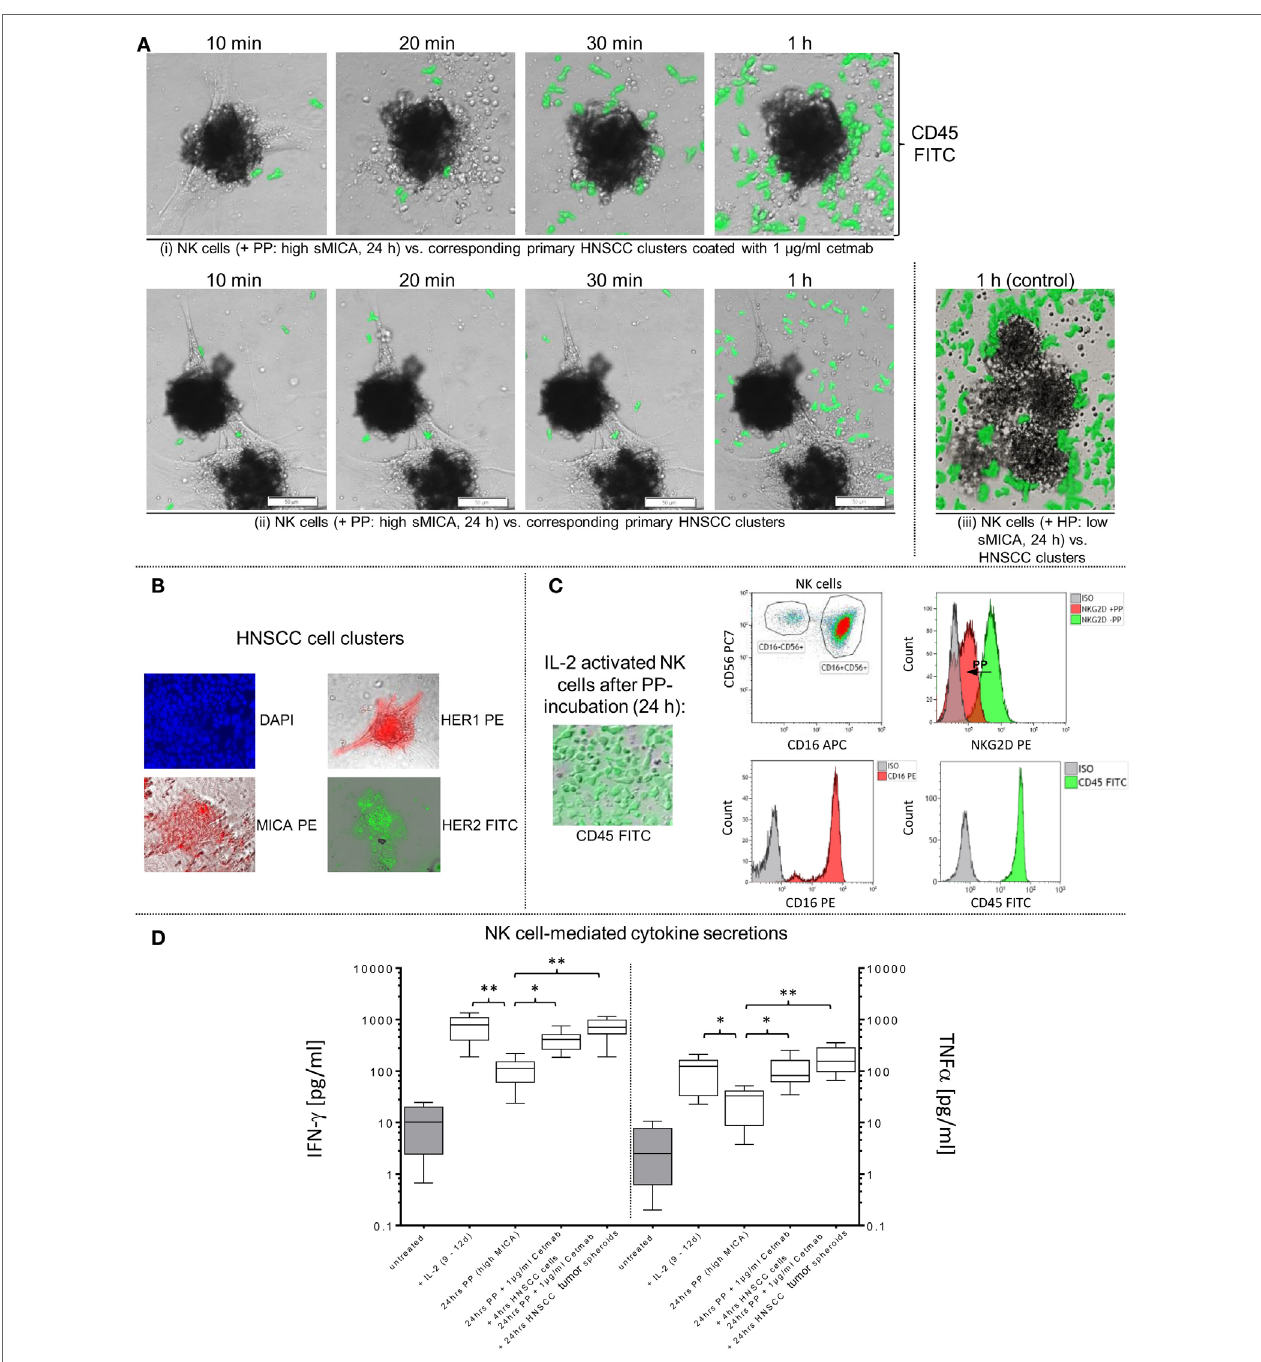
FigUre 5 | restored effector-target cell interactions via cetuximab-dependent aDcc of sMica-inhibited nK cells . (a) Activated patient NK cells were cultured (24 h) with patient plasma (PP; 1:2 diluted with X-VIVO ™ 10) containing high sMICA levels and co-incubated (1 h, approximate E:T ratios of 5:1) with corresponding HNSCC cell clusters (time of cultivation: 3–12 days) in (i) presence and (ii) absence of 1 μ g/ml cetuximab. (iii) Activated patient NK cells treated for 24 h with healthy plasma (HP [low sMICA]; 1:2 diluted with X-VIVO ™ 10) were used to monitor early effector-target cell interactions, served as a positive control. CD45 (green) for PP- and HP-treated patient NK cells were analyzed by staining with FITC-conjugated mAb, whereas co-incubated adherent HNSCC clusters were unlabeled. Before initiating these functional assays, effector and target cells were tested flow cytometrically for relevant surface markers, especially MICA, HER2 and HER1 on HNSCC cells (B) , and CD16 and NKG2D levels on PP (high sMICA/TGF- β 1 )-treated NK cells (c) . Variable IFN- γ and TNF α secretions levels during co-incubations of treated NK cells with HNSCC cell clusters or tumor spheroids in presence or absence of cetuximab were quantified and compared with untreated controls (D) . Statistically significant difference: * p ≤ 0.01 and ** p ≤